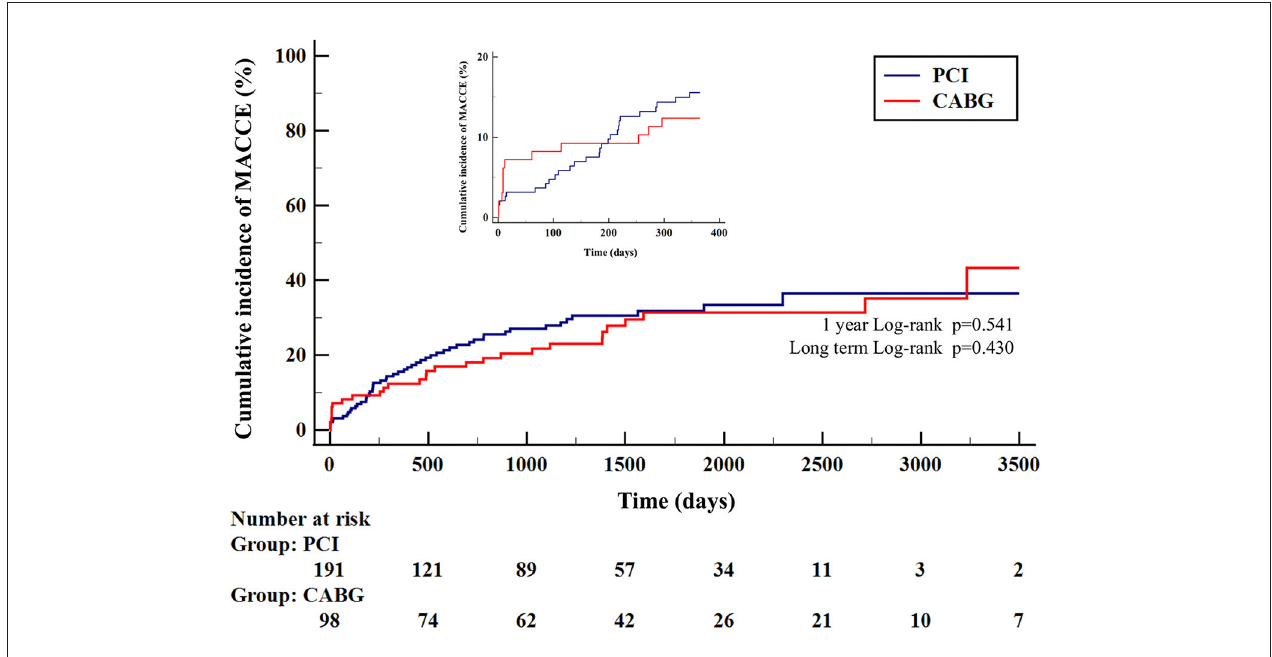
FIGURE 1 | Kaplan–Meier curves for MACCE according to type of treatment. Major adverse cardiac and cerebrovascular events (MACCE) is the composite of target vessel revascularization, myocardial infarction, stroke, or cardiac death. CABG, coronary artery bypass grafting; PCI, percutaneous coronary